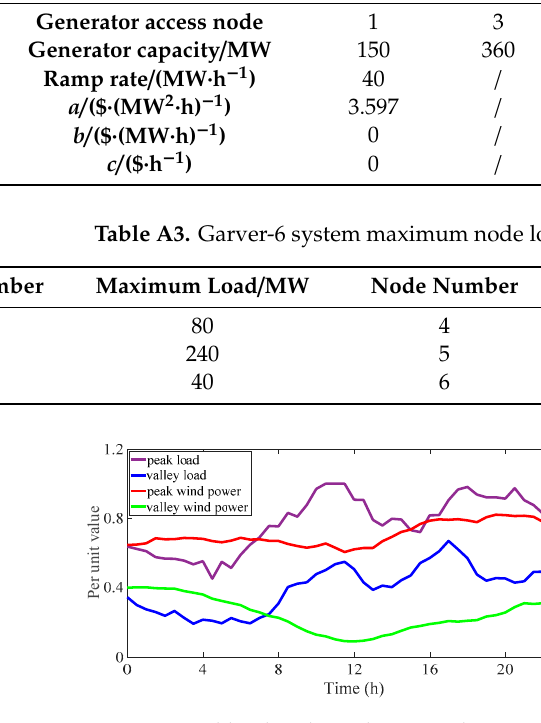
Figure A1. Typical load and wind power planning scenarios.